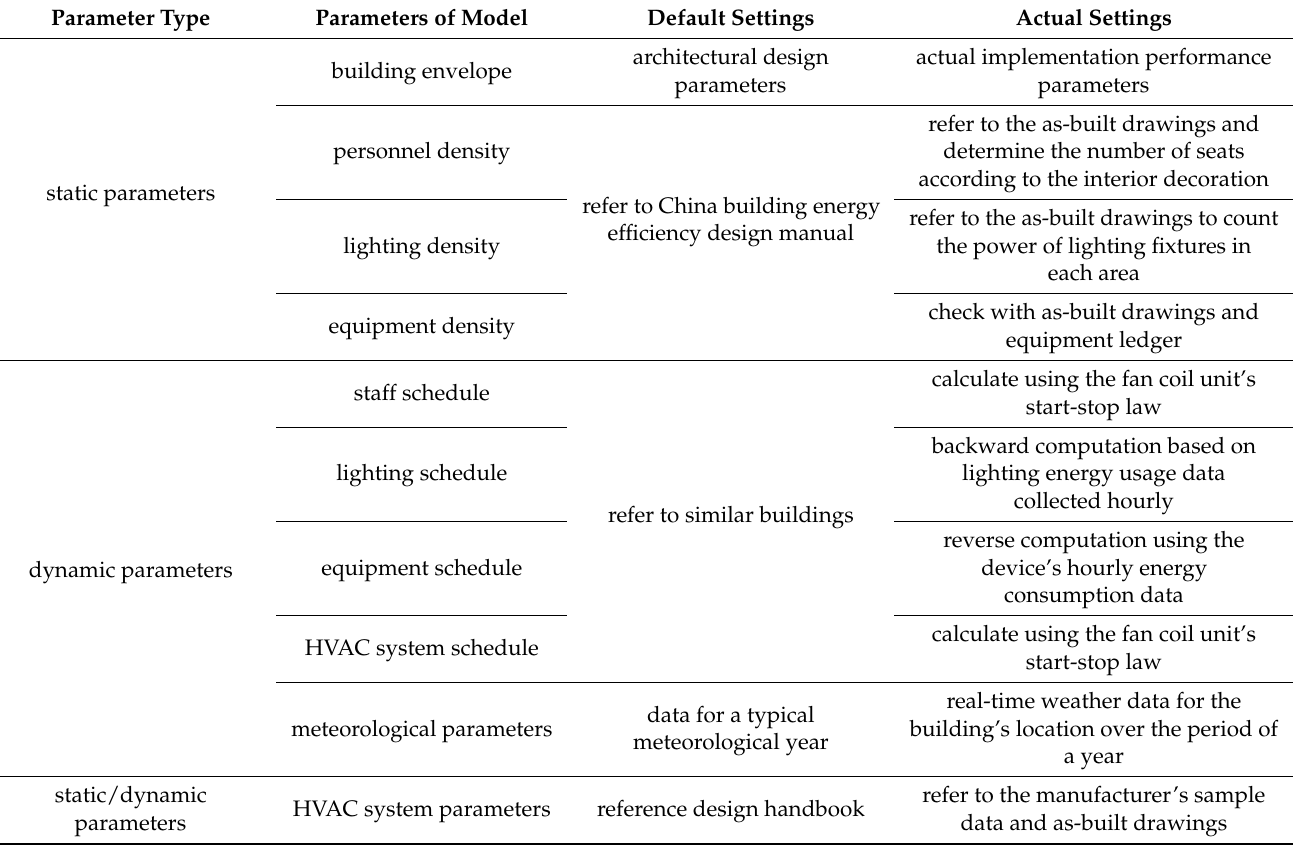
Table 1. Calibration content of physical model input